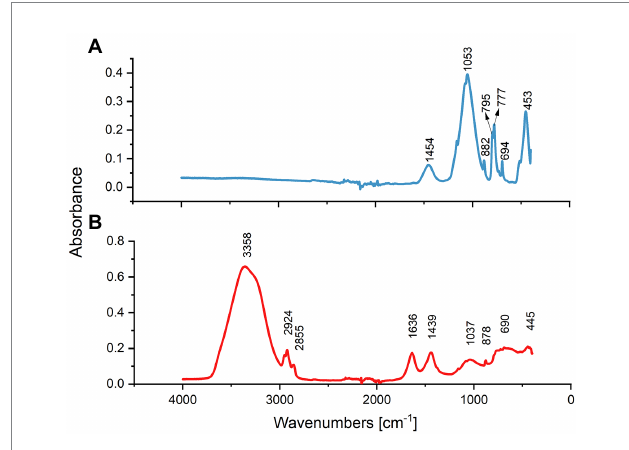
FIGURE 1 FTIR spectral analysis of treated and untreated sand samples. (A) Spectrum of treated sand indicating that SiO 2 formed the sample predominantly. (B) Spectrum of the untreated oilfield sand indicating the presence of O-H and C-H functional